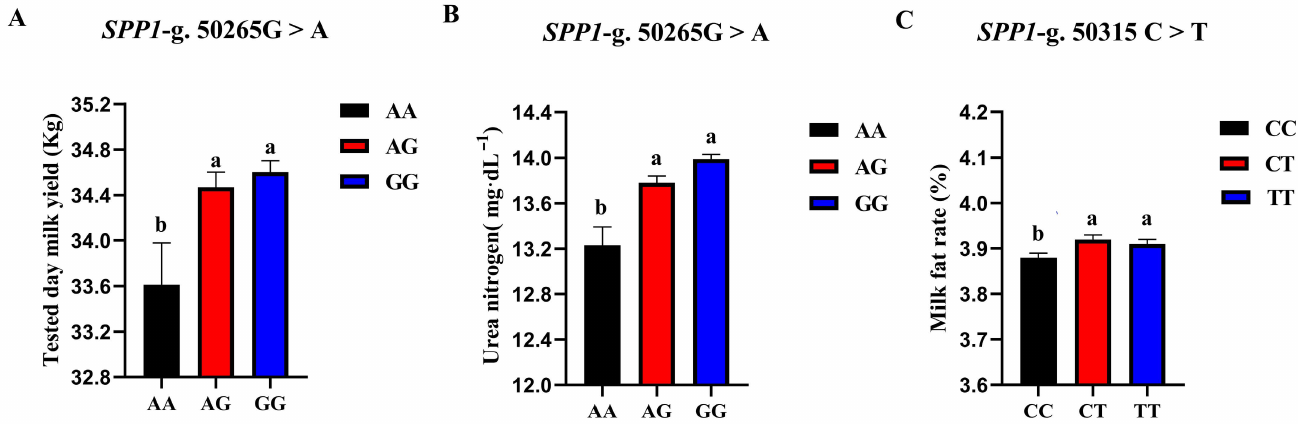
Figure 8. SPP1 -g.50265G > A and SPP1 -g.50315C > T loci on the productive performance of